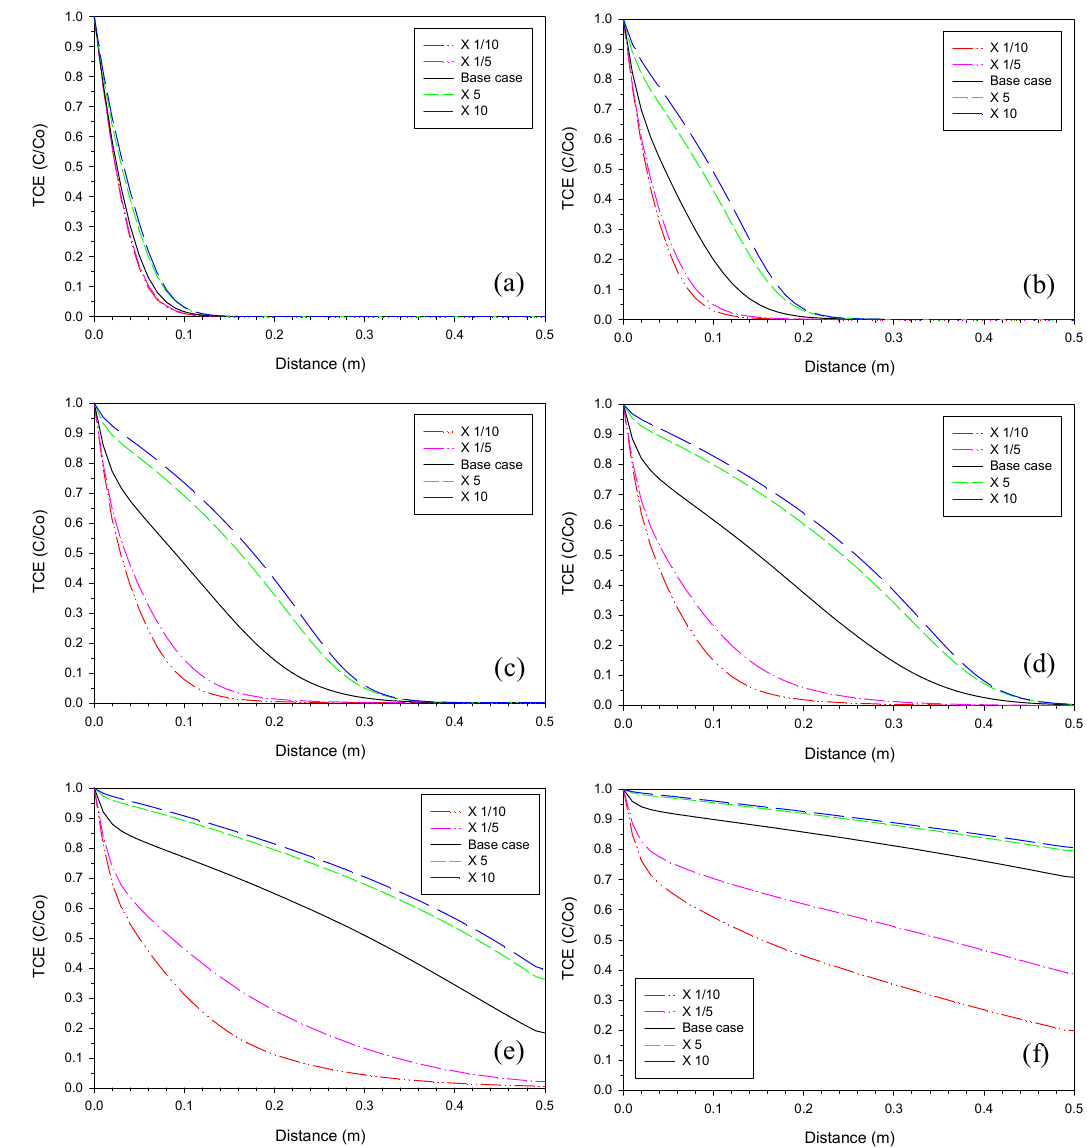
Figure 3. Sensitivity analysis of aragonite precipitation rate. TCE profiles on ( a ) Day 4, ( b ) Day 25, ( c ) Day 54, ( d ) Day 87, ( e ) Day 164, and ( f ) Day 410 with value of the base case, × 1/10, × 1/5, × 5, and × 10.